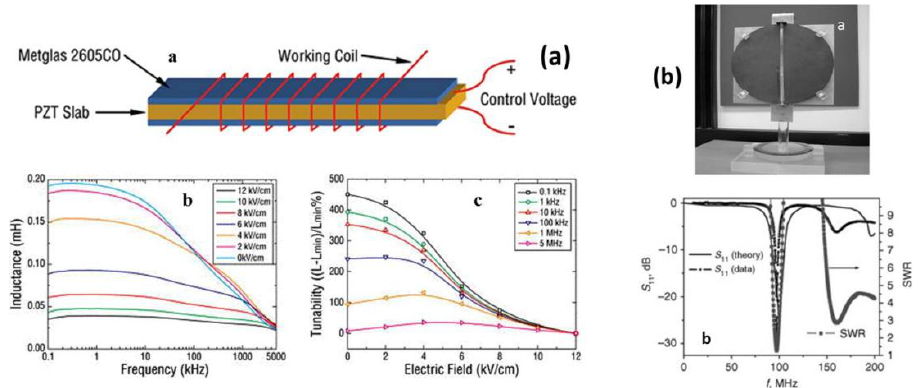
Figure 19. ( a ) Schematic of the magnetoelectric inductor, inductance spectra, and inductance tunability at different frequencies and electric field [135]; ( b ) Miniature microstrip antenna on NZFO/BST composite substrate, measured and estimated return loss and measured SWR for the antenna [140].